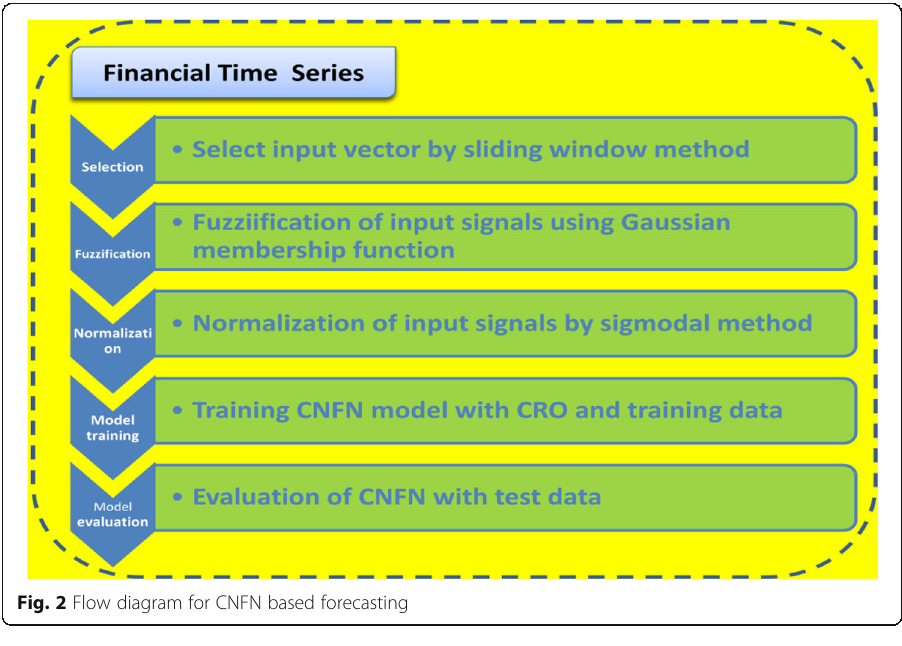
Fig. 2 Flow diagram for CNFN based